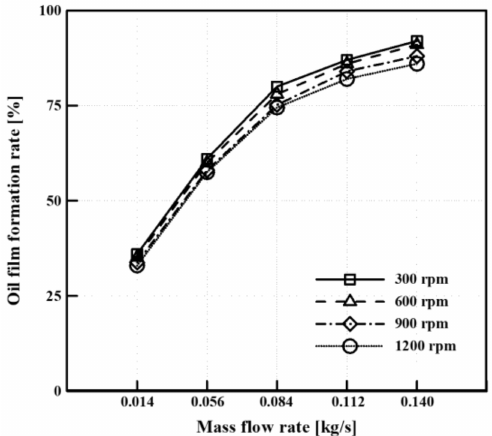
Figure 8. Oil film formation rate according to the mass flow rate at 60 ◦ C.